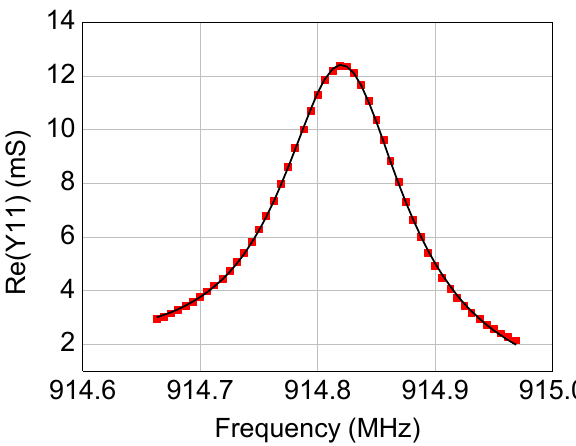
Figure 4. Comparison between (red symbols) measurements and (black line) Lorentzian fitting of the frequency-dependent behavior of Re(Y 11 ) for the 915 MHz SAW resonator.